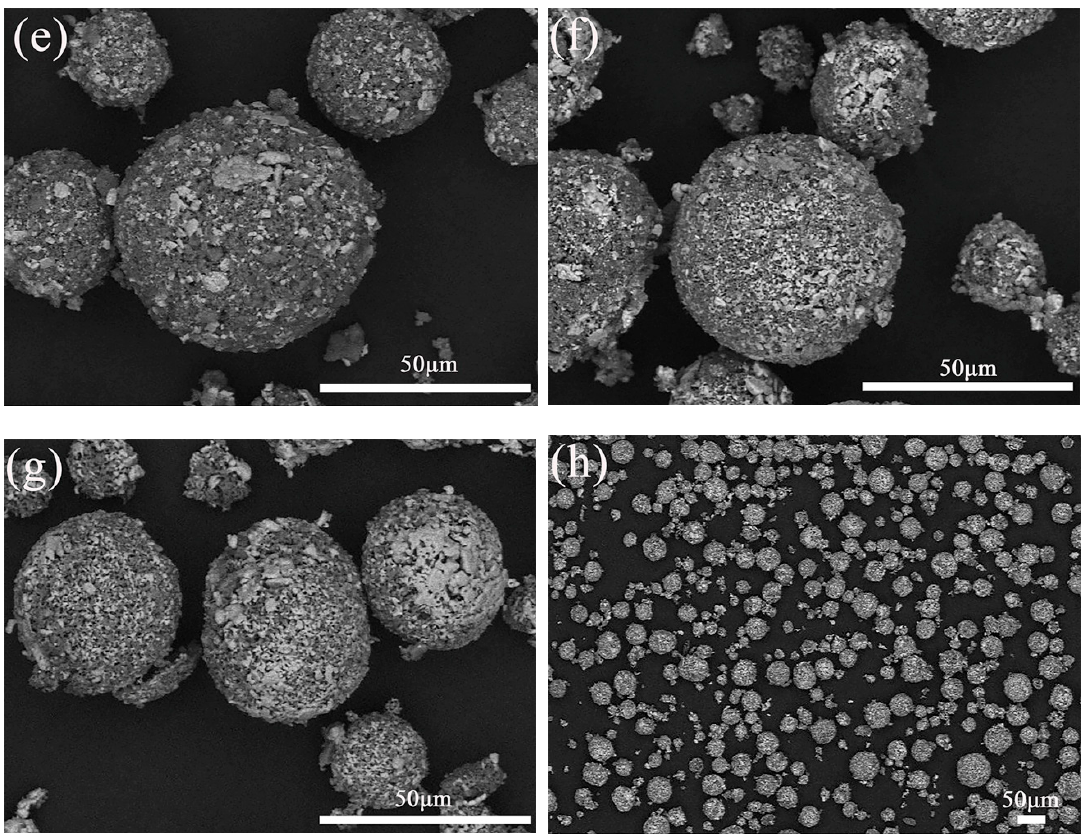
Figure 4. Microscopic morphologies of granulated powders calcined for 2 h at different temperatures: ( a ) 900 °C; ( b ) 1000 °C; ( c ) 1100 °C; ( d ) 1200 °C; ( e ) 1300 °C; ( f ) 1400 °C; ( g ) 1500 °C; ( h ) 1500 °C (×200).